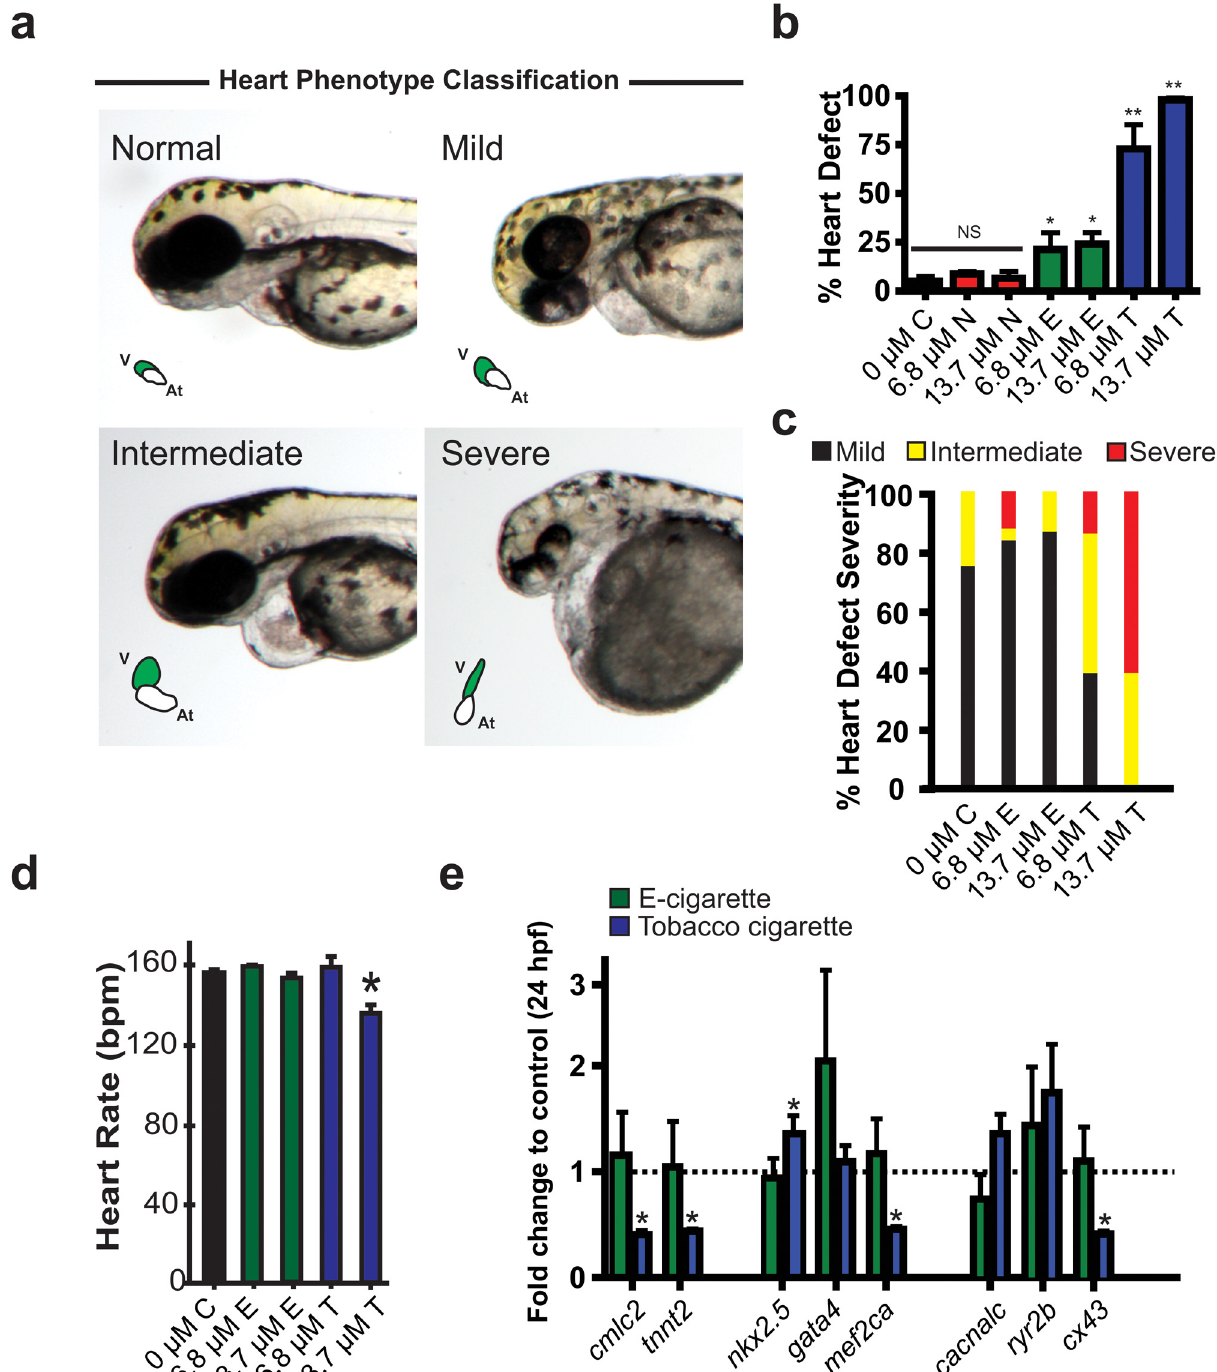
Fig 2. Cardiac developmental defects observed in zebrafish treated with cigarette smoke. (a) Representative whole mount images of zebrafish at 72 hpe showing normal, mild, intermediate, and severe cardiac developmental defects. v = ventricle, At = atrium. (b-c) Analysis of percent zebrafish with heart defects (b) severity of heart defects and (c). (d) Analysis of heart function in control, e-cigarette and tobacco treated groups at 72 hpe. (e) Quantitative RT-PCR analysis (fold change from control) of a panel of genes with critical roles in early heart development at 24 hpe. n (cid:3) 3 (independent experiments with each n containing between 24 – 48 animals per treatment). For qRT-PCR, n = 3 with each n consisting of 28 – 35 embryos from independent breeding pools. * P < 0.05, hpe = hours post exposure; N = Nicotine, E = E-cigarette, T =